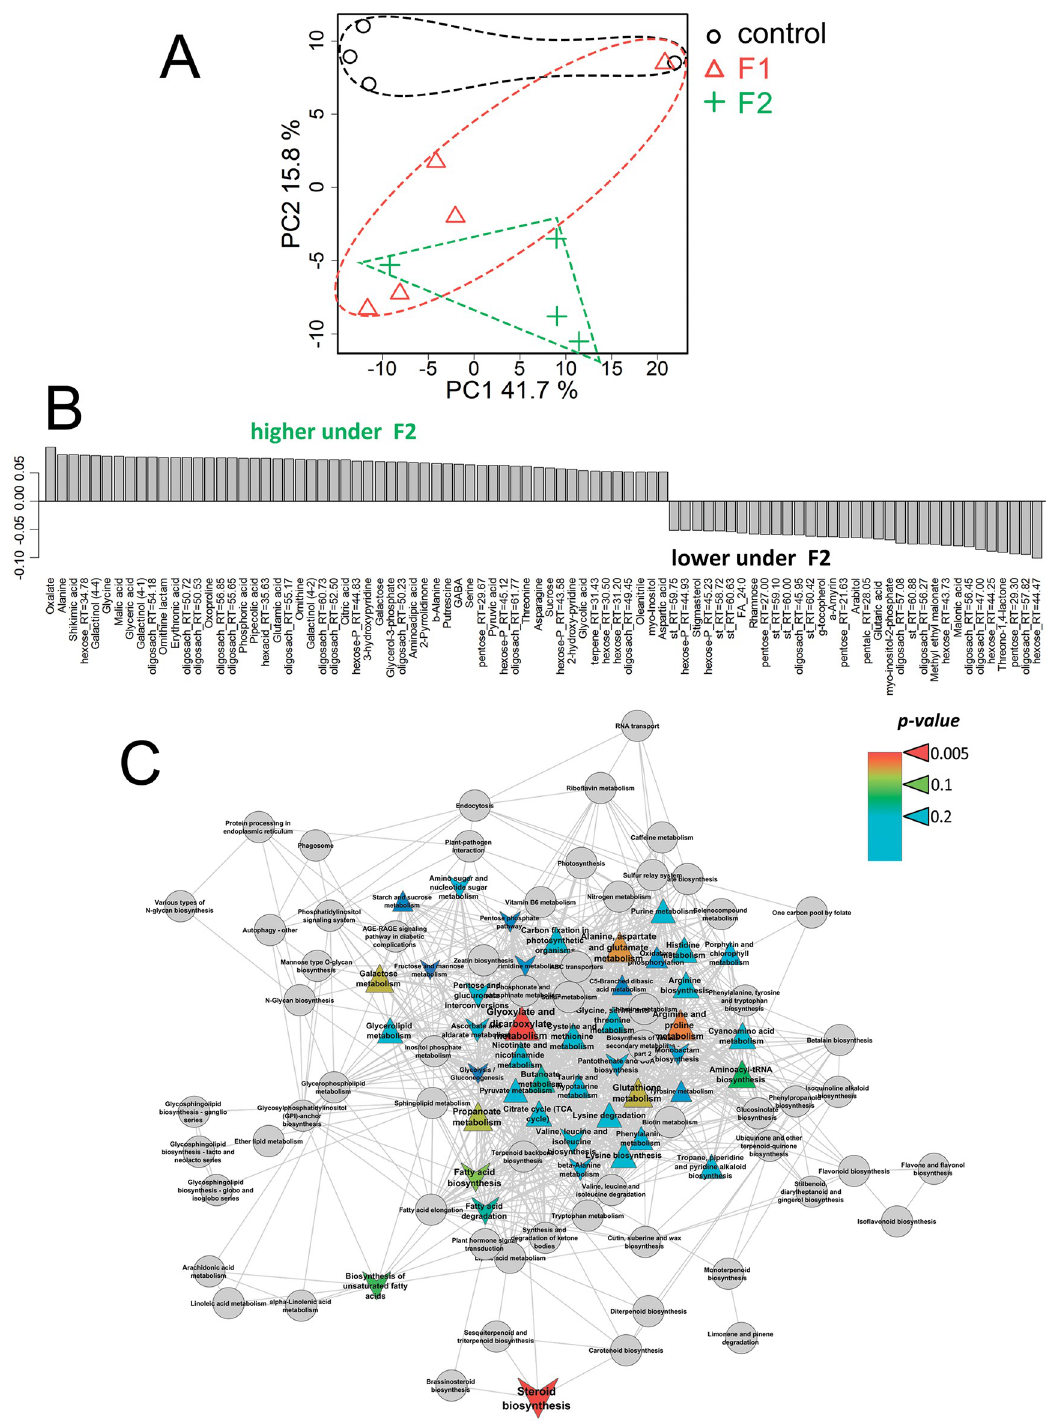
Fig 10. Fullerenols effects on leaf metabolome of the Fe II -deficient cucumber plants grown hydroponically in a nutrient solution with or without the supply of 2 (F2) mg L -1 fullerenol for 10 days. A—PCA score plot, B—Bar plots of loadings of predictive component (VIP > 1) derived from OPLS-DA, C—Enrichment analysis. Colours represent p- values, shape: Δ — activation induced by F1 and v—repression by Fq, sizes: The power of effect represented as |NES|.